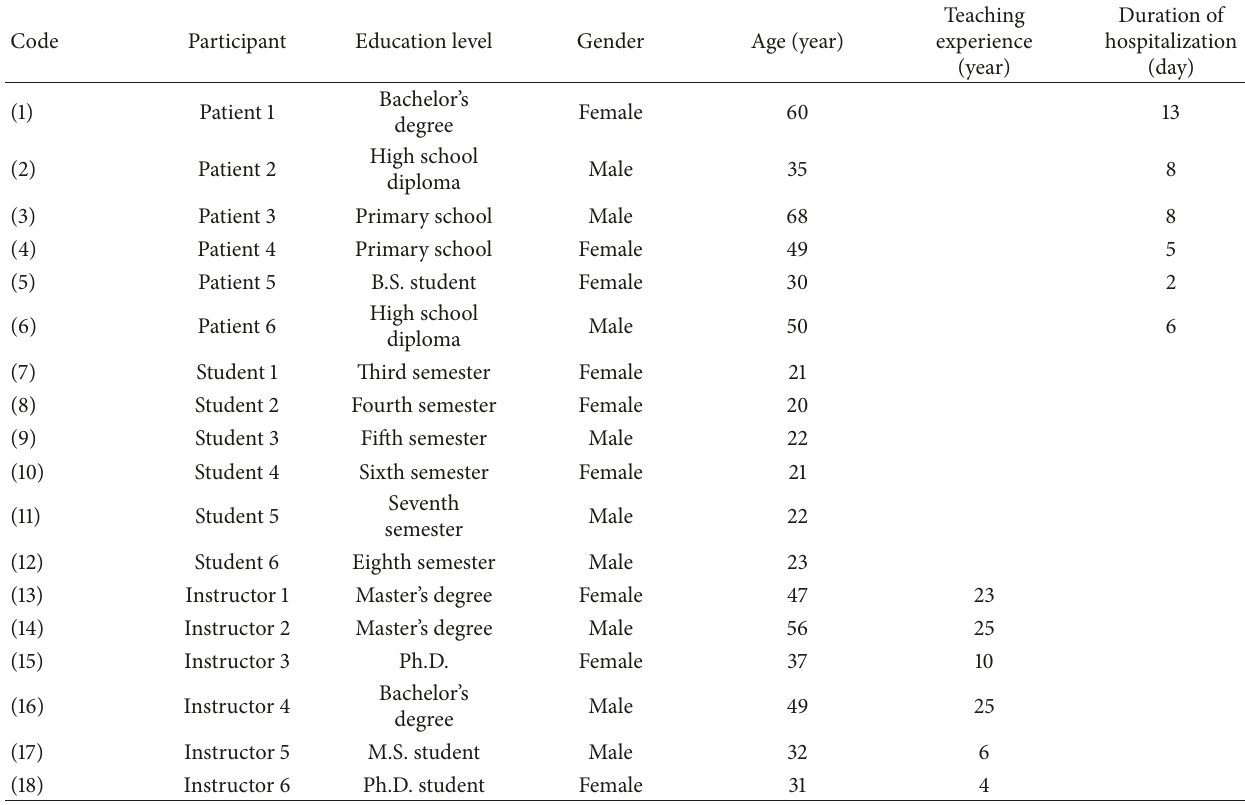
Table 1: Demographic characteristics of the participants.